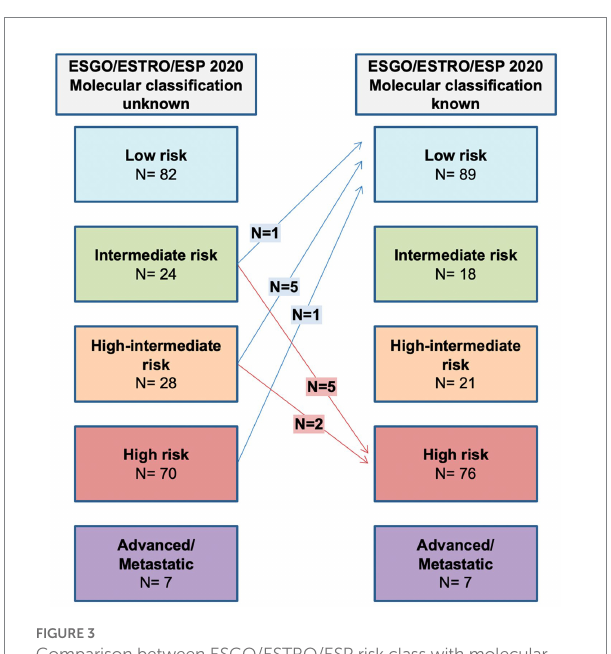
FIGURE 3 Comparison between ESGO/ESTRO/ESP risk class with molecular classification unknown and ESGO/ESTRO/ESP risk class with molecular classification